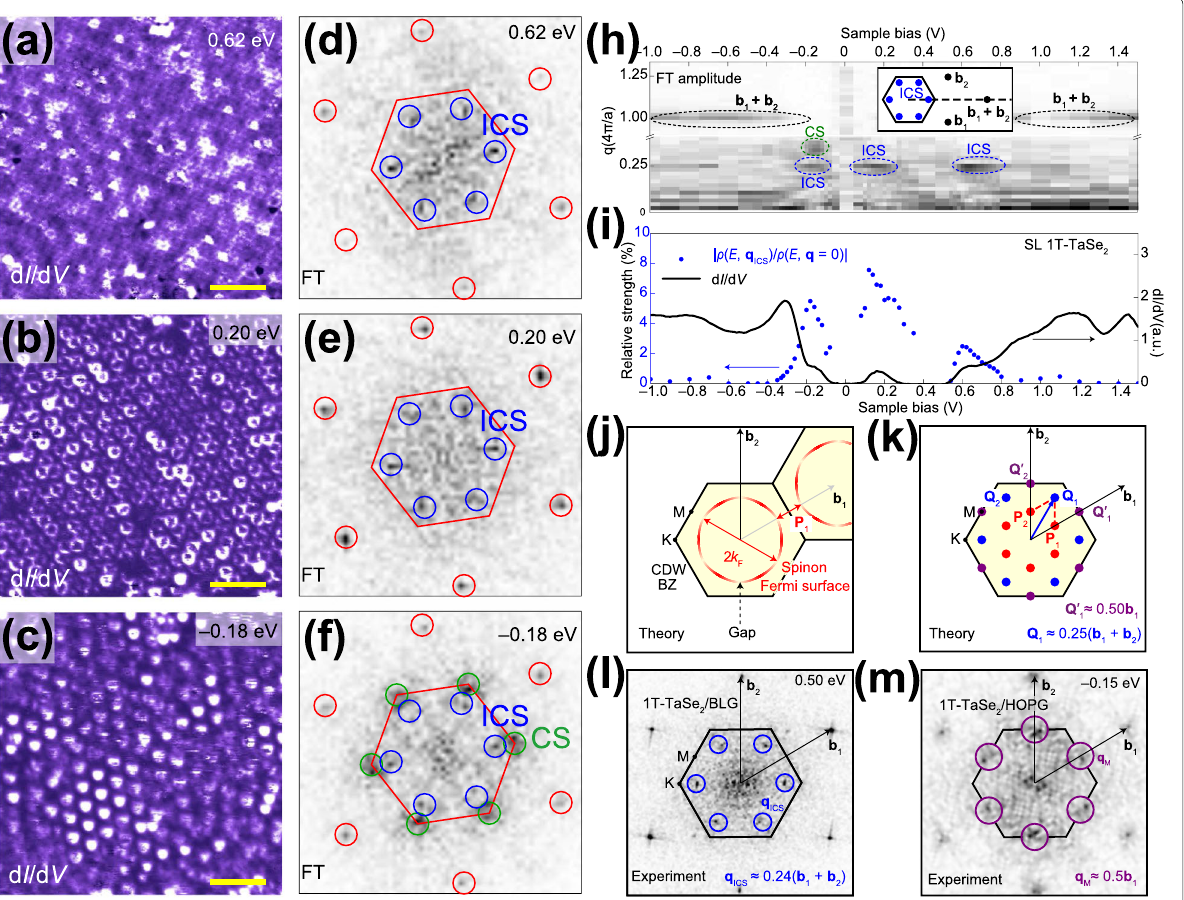
Fig. 13 Super-modulations in single-layer 1 T -TaSe 2 . a – c dI/dV maps at different energies and (d-f) their corresponding Fourier transforms (FTs). h Plot of FT amplitude as a function of both wavevector q = q ( b 1 + b 2 ) along the (cid:3) − K direction and sample bias voltage. i Energy dependence of the incommensurate super-modulation strength (blue dots) and the reference dI/dV spectrum (black curve). j – m Super-modulation periodicities predicted from the spinon Fermi surface compared with experiment. Taken from ref.